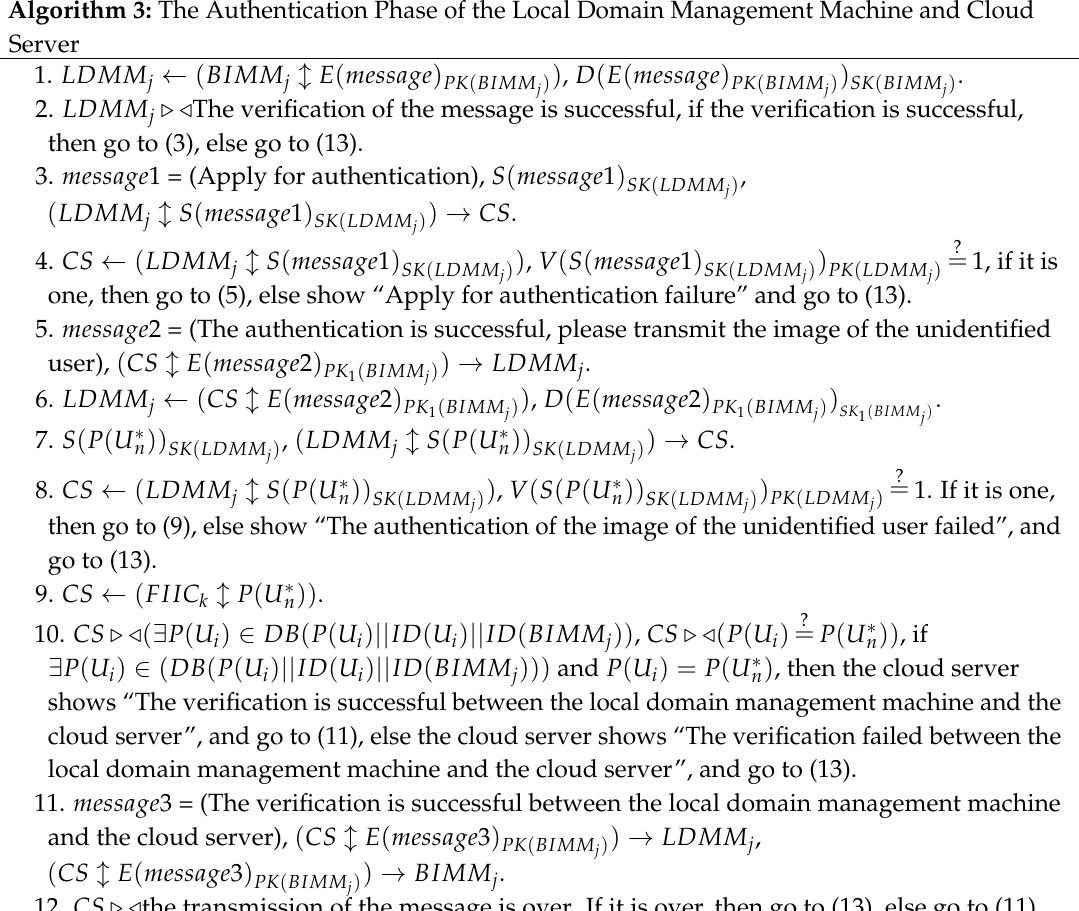
Algorithm 3: The Authentication Phase of the Local Domain Management Machine and Cloud